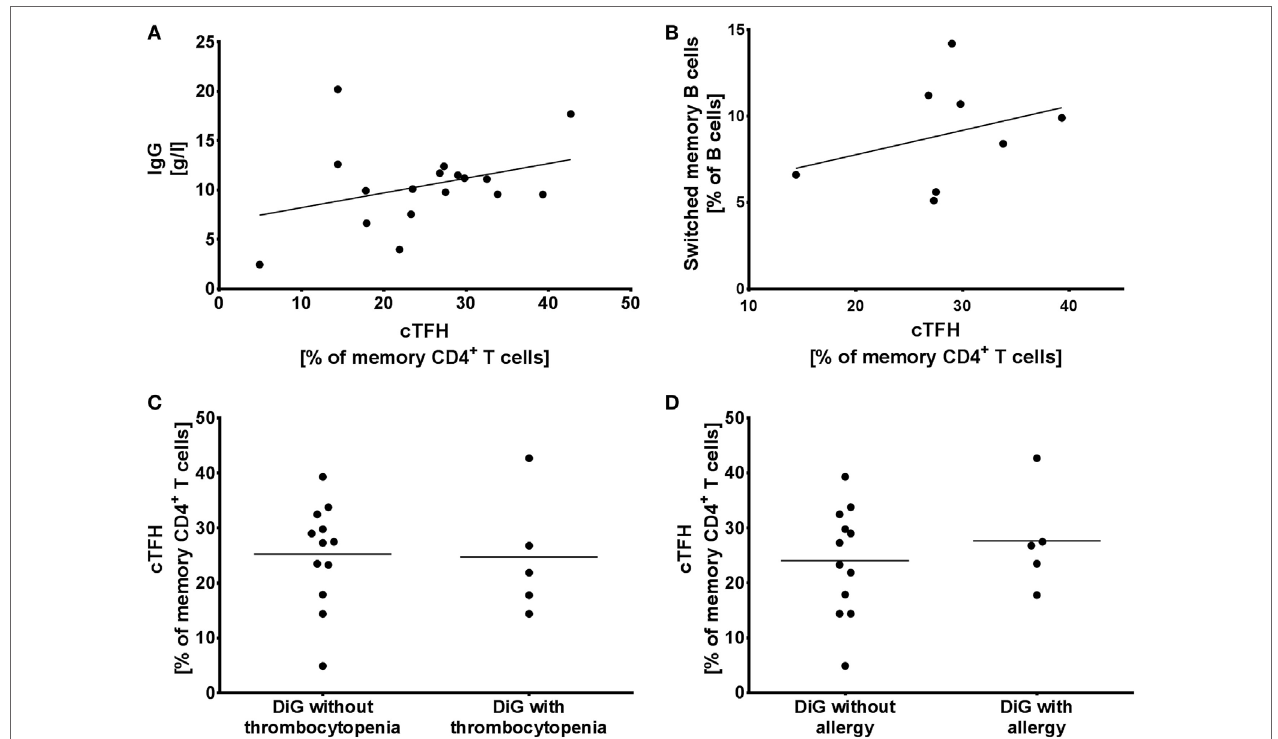
FigUre 3 | Circulating follicular helper T cells (cTFH) in humoral immune dysregulation, autoimmunity, and allergy. (a) Proportion of cTFHs in memory CD4 + T cells compared to serum IgG levels and (b) switched memory B cells in DiGeorge syndrome patients, shown with linear regression trendlines. (c) cTFHs in DiGeorge syndrome patients without/with thrombocytopenia and (D) without/with allergy (lines denote